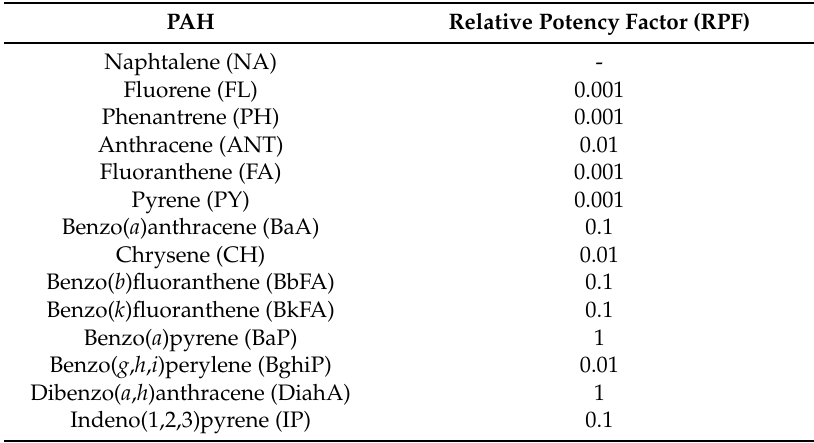
Table 3. Relative potency factor [2].